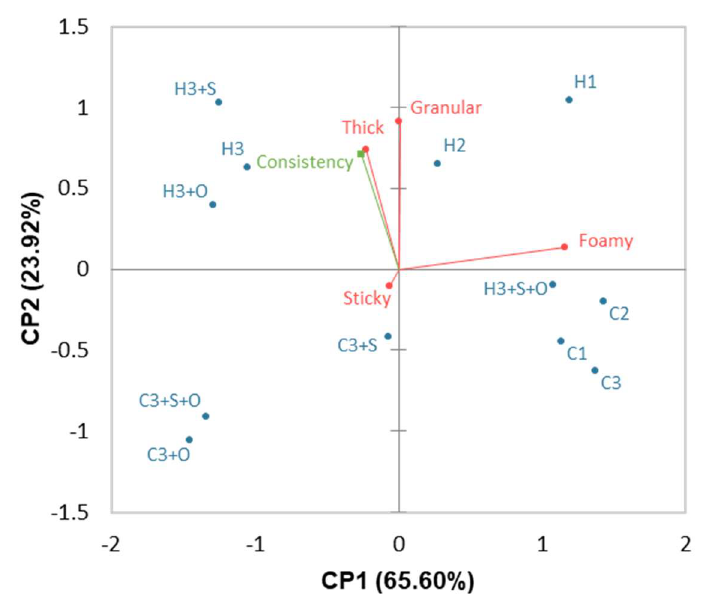
Figure 1. Biplot representation of the PCA (covariance) of the texture sensory descriptors (variables in red) and the consistency measured by back-extrusion (supplementary variable in green) of the 12 gels defined in Table 1.